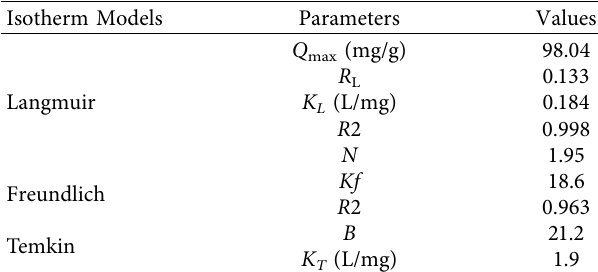
Figure 12: Langmuir (a), Freundlich (b), and Temkin (c) models for Cr(VI) ion adsorption by the nanocomposite adsorbent (BMNC). Table 8: Parameters of isotherm models for Cr(VI) ion adsorption onto the nanocomposite adsorbent